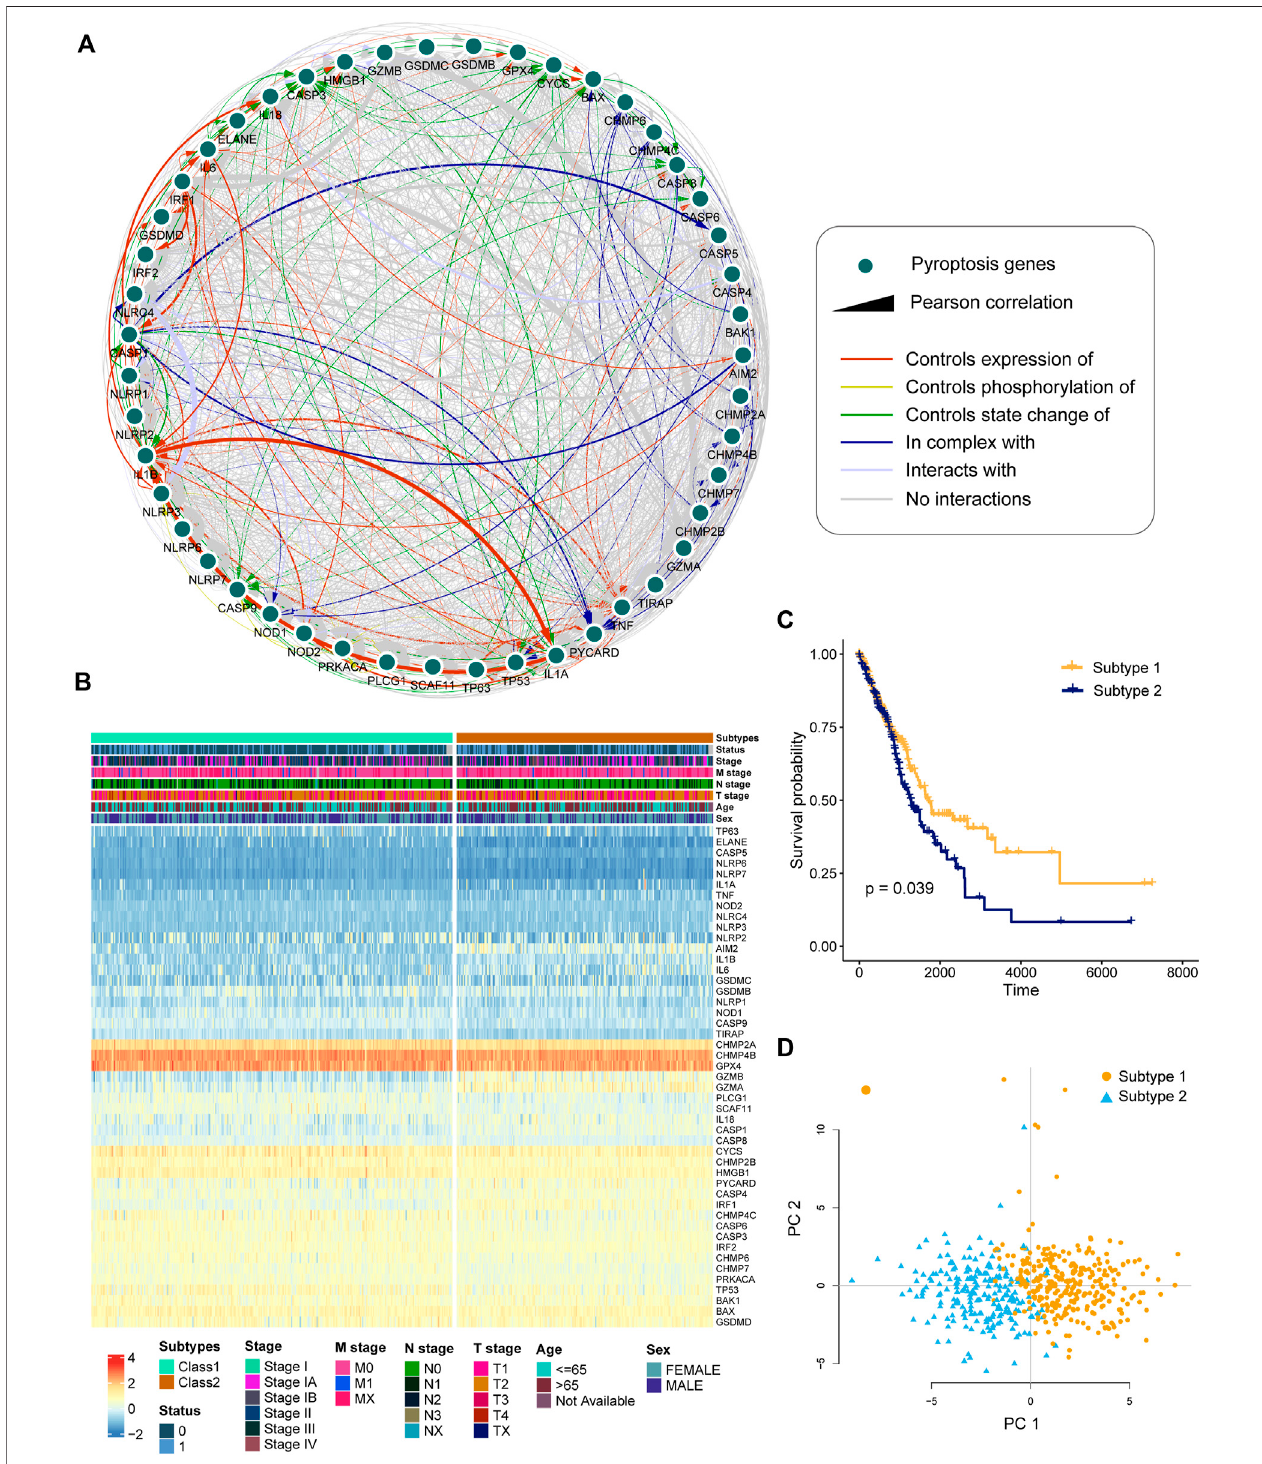
FIGURE 2 | Identi fi cation of pyroptosis-related subtypes by clustering. (A) Interactions and co-expression among pyroptosis-related genes in LUAD. The colored edgesrepresentprotein – proteininteractions,withthelinethicknessindicatingthestrengthofthecorrelation betweenpyroptosis-relatedgenes. (B) Twoheterogeneous subtypes (subtype 1 and subtype 2) were identi fi ed according to unsupervised K-means clustering. (C) Kaplan – Meier curves of OS between subtype 1 and subtype 2. (D) PCA analysis demonstrating a remarkable difference in expression of pyroptosis-related genes between the two subtypes.